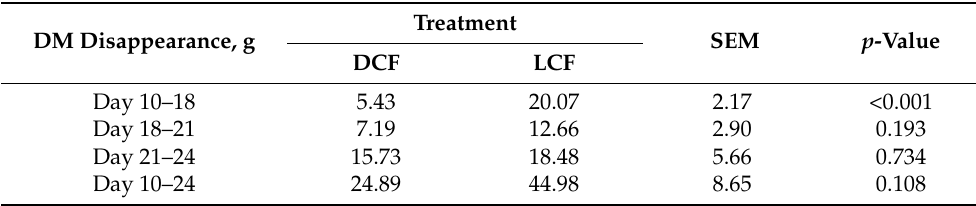
Table 2. Average dry matter (DM) disappearance per pig for litters fed a dry (DCF) or liquid creep feed (LCF) day 10–24 postpartum.